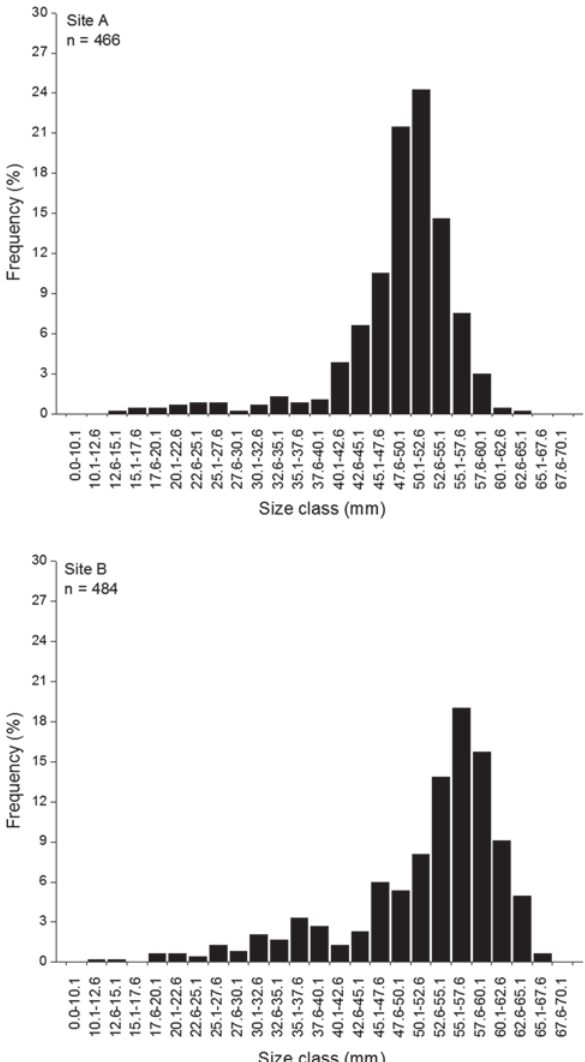
Figure 2. Tagelus plebeius . Size frequency distribution in the sites A and B of Enseada